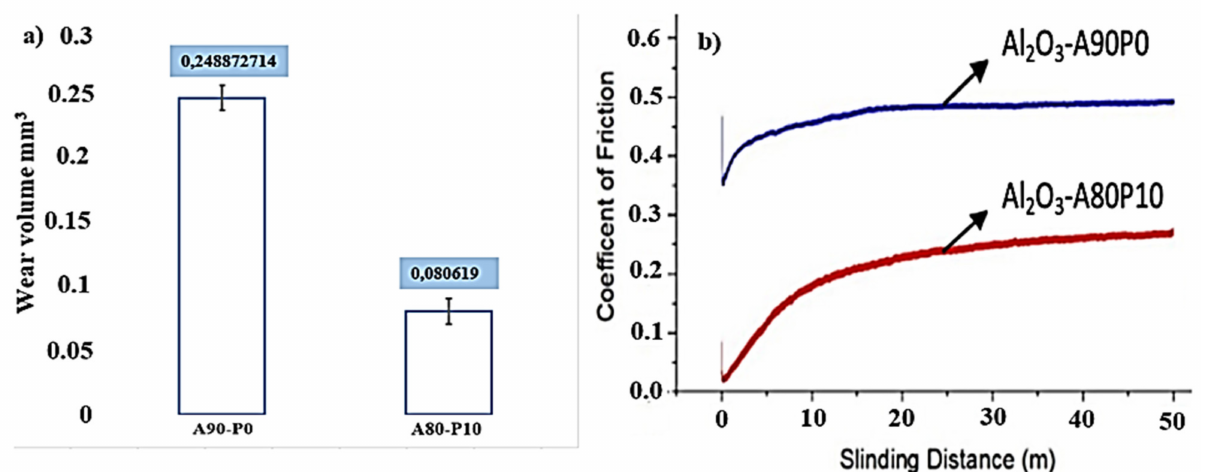
Figure 4. The wear volume ( a ) and the coefficient ( b ) of A90-P0 and A80-P10